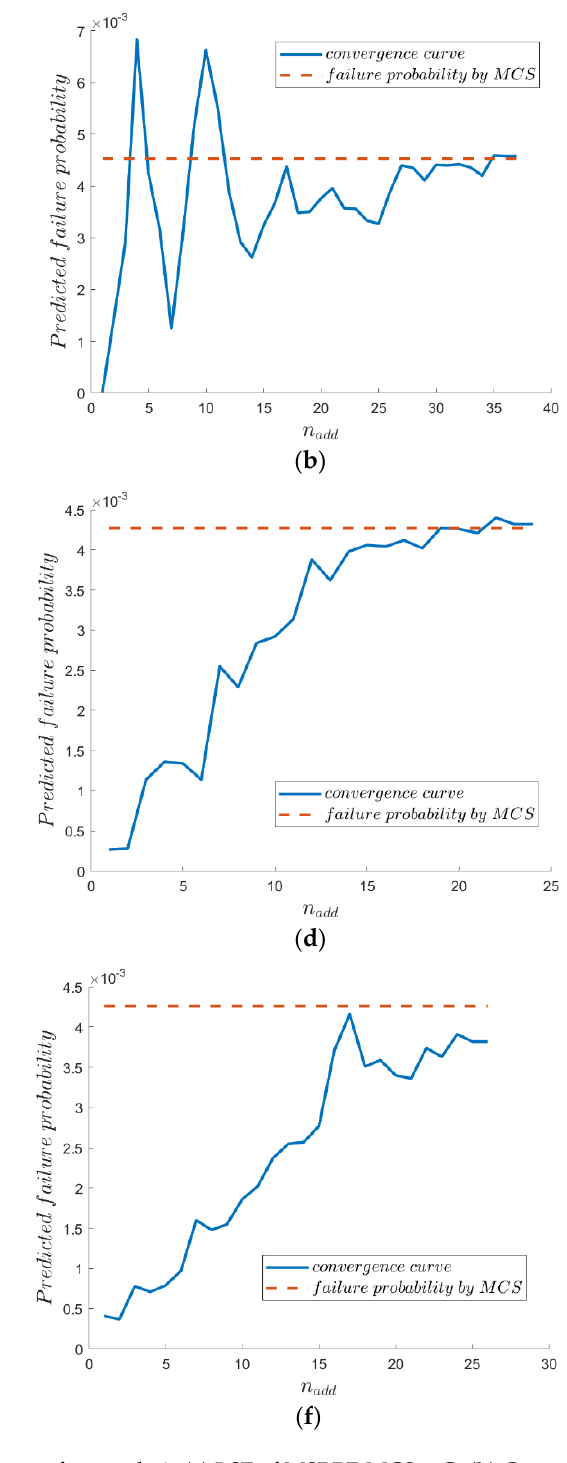
Figure 6. LSFs and convergence curves of example 1. ( a ) LSF of MSRBF-MCS + G. ( b ) Convergence curve of MSRBF-MCS + G. ( c ) LSF of MSRBF-MCS + M. ( d ) Convergence curve of MSRBF-MCS + M. ( e ) LSF of MSRBF-MCS + IM. ( f ) Convergence curve of MSRBF-MCS + IM.